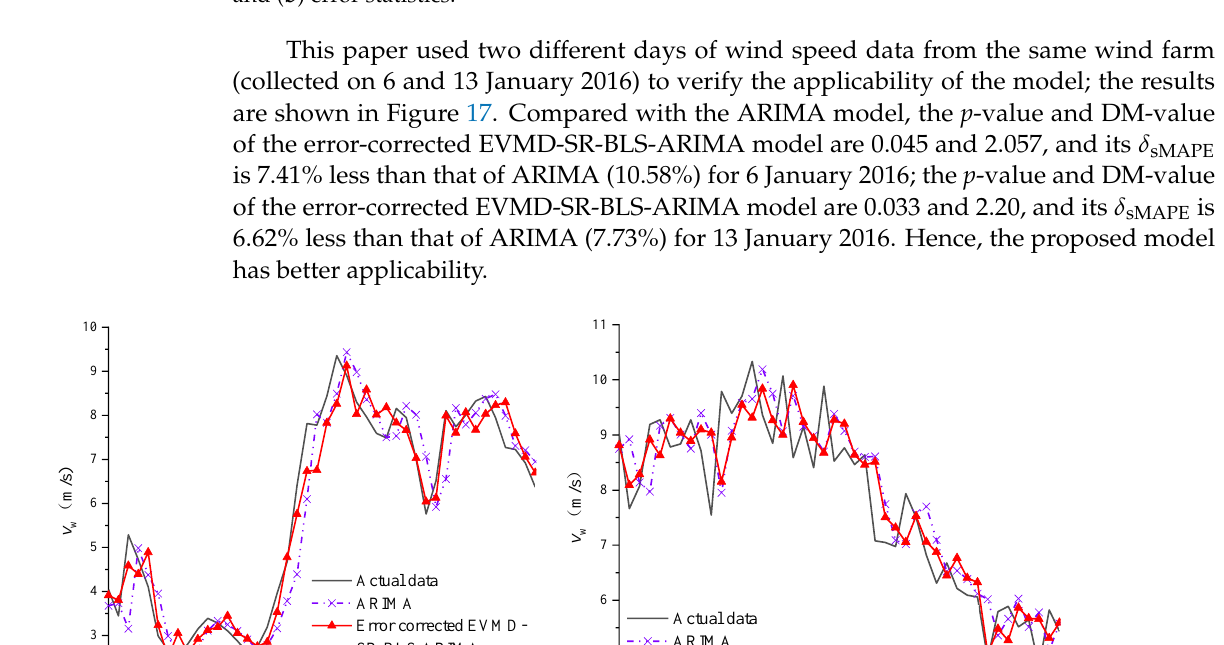
Figure 16. Forecasting errors and statistics of EVMD-SR-BLS-ARIMA models: ( a ) forecasting error and ( b ) error statistics.